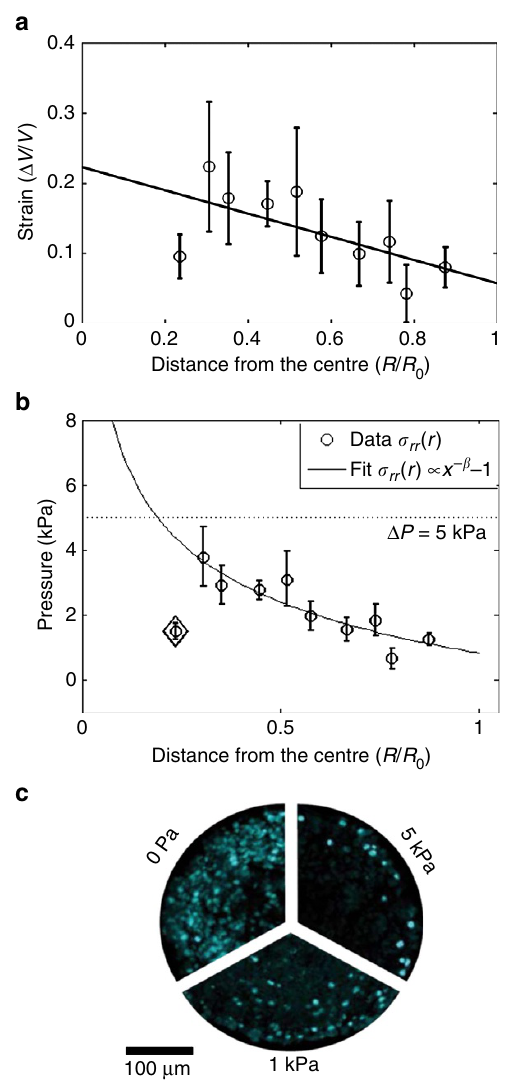
Figure 4 | Pressure distribution in CT26 spheroids upon 5kPa compressive stress. ( a ) Strain profile of microbeads | V(P) - V 0 |/ V 0 ) along the radius of the spheroid. Data points are grouped together in bins, with the error bar being a s.e.m. and the position being an average position within the bin. The solid line is a linear fit to all experimental data points and it indicates an increasing strain towards the core of the spheroids. ( b ) Pressure profile obtained with a stress/strain calibration curve of PAA microbeads. The solid line represents a fit of r b with b ¼ (cid:2) 0.21 ± 0.1. Error bars are s.e.m. The point for r B 0.22 (losange) has been omitted in this fit. ( c ) Cellular proliferation along the radius in a control (0Pa) and spheroids grown under 1 and 5kPa pressure. Images represent immunostainning for Ki-67. Reprinted with permission from Montel et al.